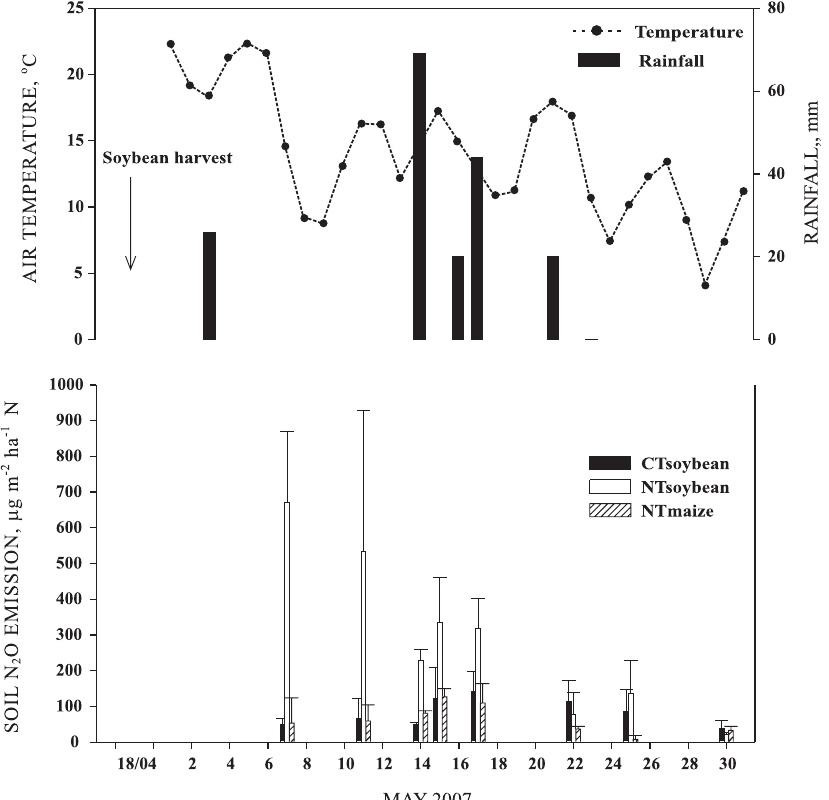
Figure 1. Rainfall, air temperature in May, and nitrous oxide (N O) emission from a subtropical Oxisol in 2 autumn (May 7 to 30, 2007), in Southern Brazil as influenced by tillage system (conventional CT and no- tillage NT) after soybean (CTsoybean and NTsoybean) and after maize harvest (NTmaize), in the rotation sequence black oat/soybean/black oat + common vetch/maize/radish oil/wheat/soybean. Bars represent the mean standard